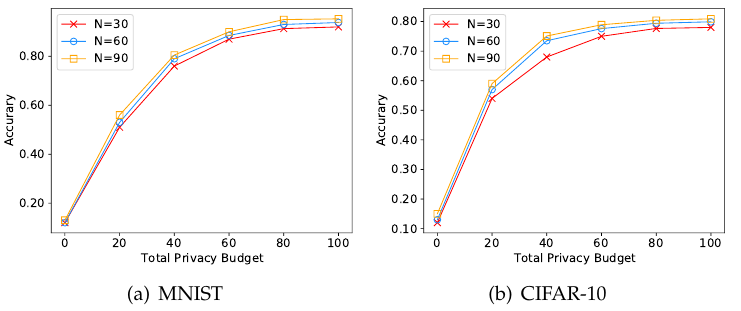
Figure 6. The model accuracy of ADPML under different total privacy budgets for 30, 60, and 90